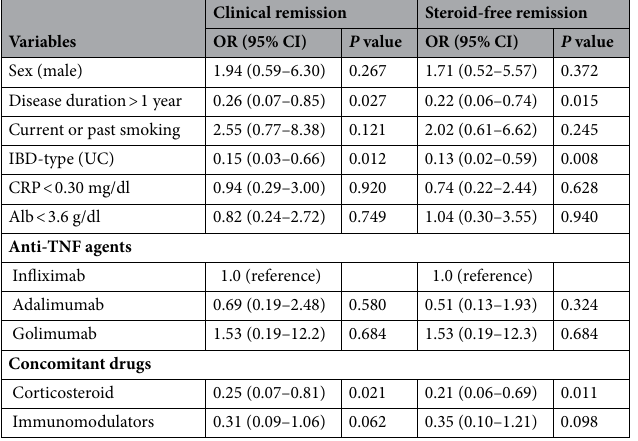
Table 3. Univariate analysis of factors for clinical or steroid-free remission after 52 weeks of anti-TNF treatment in Elderly-EO (n = 53). Alb albumin, Anti-TNF anti-tumor necrosis factor, CI confidence interval, CRP C-reactive protein, EO elderly onset, IBD inflammatory bowel disease, OR odds ratio, UC ulcerative